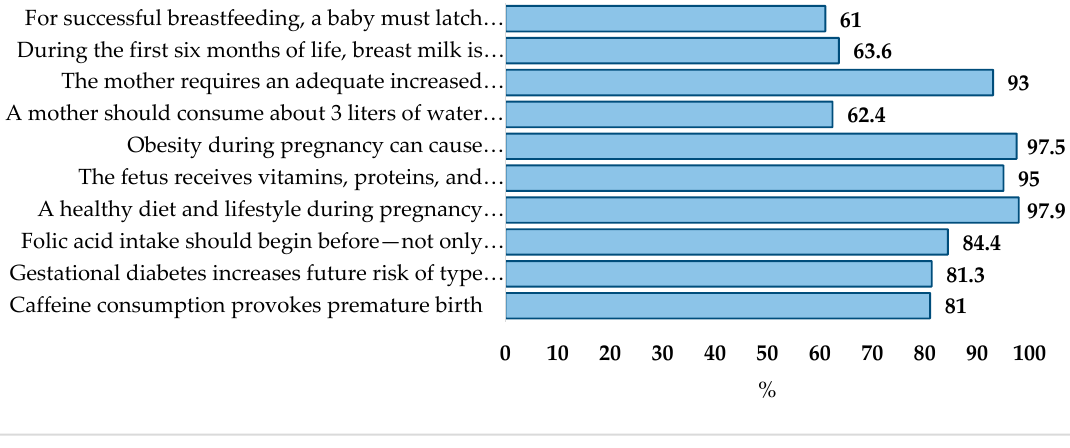
Figure 1. Distribution of participants that had correct knowledge, (%).